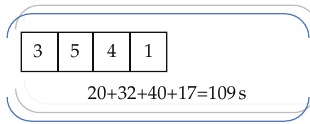
Figure 9: Result